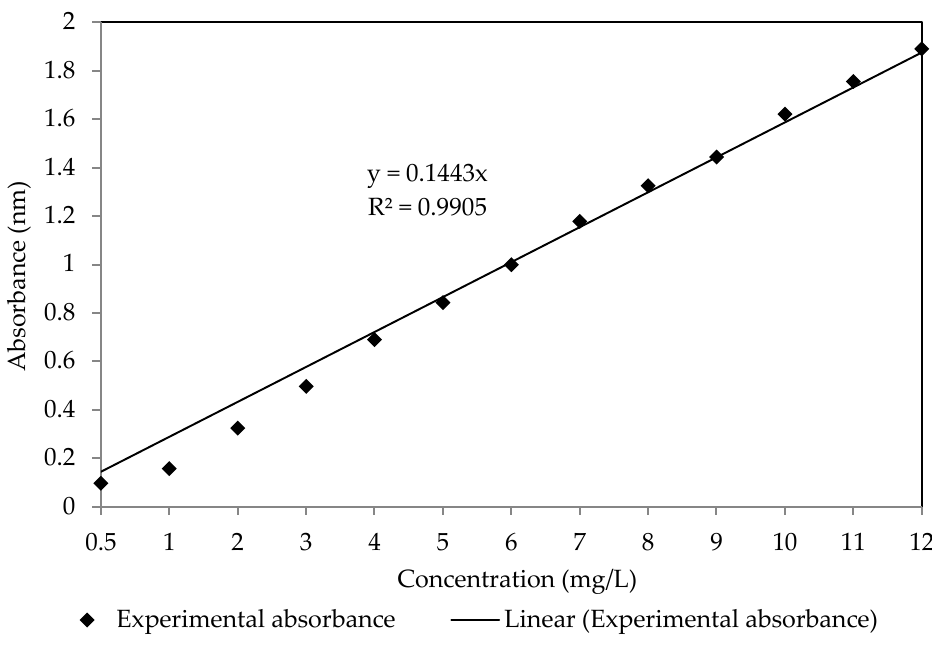
Figure 4. MG calibration curve.